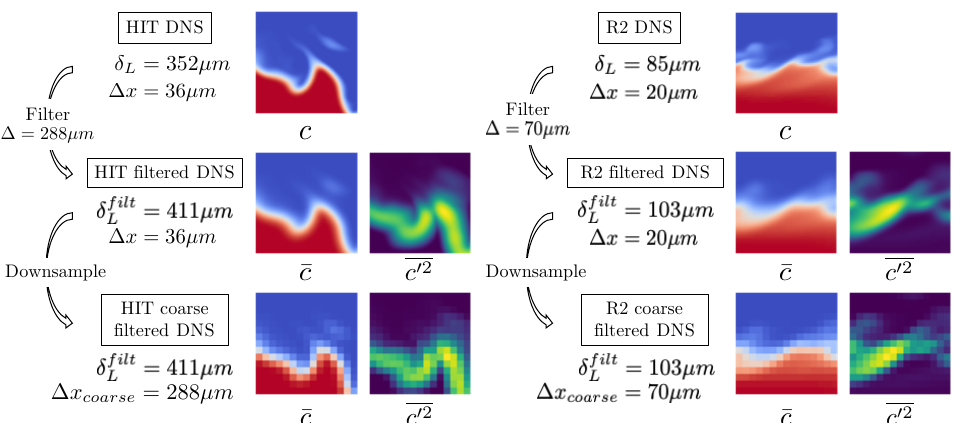
Figure 4. Summary of the filtering process for the HIT and R2 for ∆ / δ L = 0.81, illustrated with enlargements of the corresponding